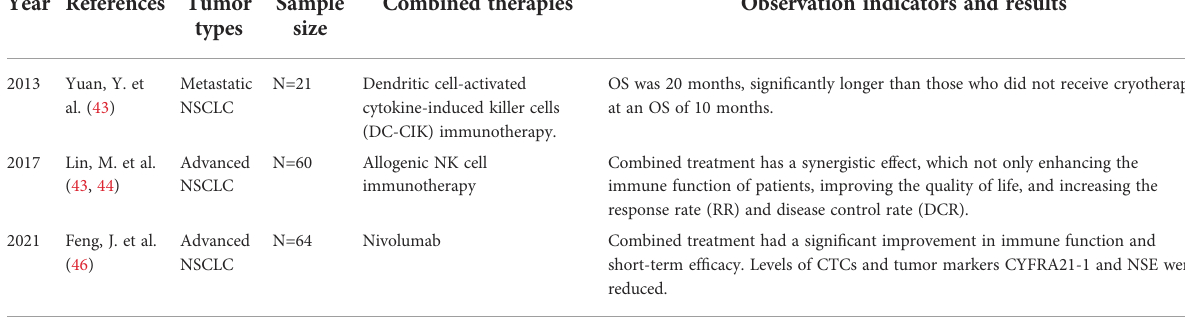
TABLE 2 Cryoimmunotherapy for lung tumors. Year References Tumor